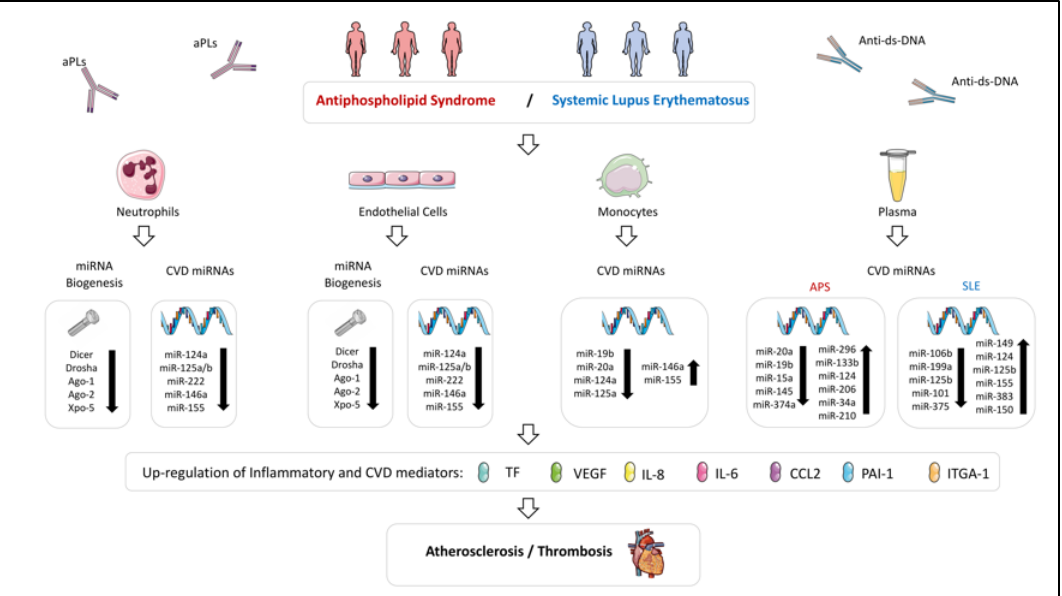
Figure 2. Altered expression of miRNAs and their biogenesis machinery in immune cells influencing both atherosclerosis and thrombosis processes in Antiphospholipid Syndrome and Systemic Lupus Erythematosus. miRNA expression profile is dysregulated in immune cells and plasma of APS and SLE patients. Those altered miRNAs could modulate the expression of inflammatory and CVD mediators, being associated with clinical pathological features of these diseases, such as atherosclerosis and thrombosis. The key role of the autoantibodies present in these diseases in the alteration of the miRNA profile has been confirmed indeed through in vitro studies.